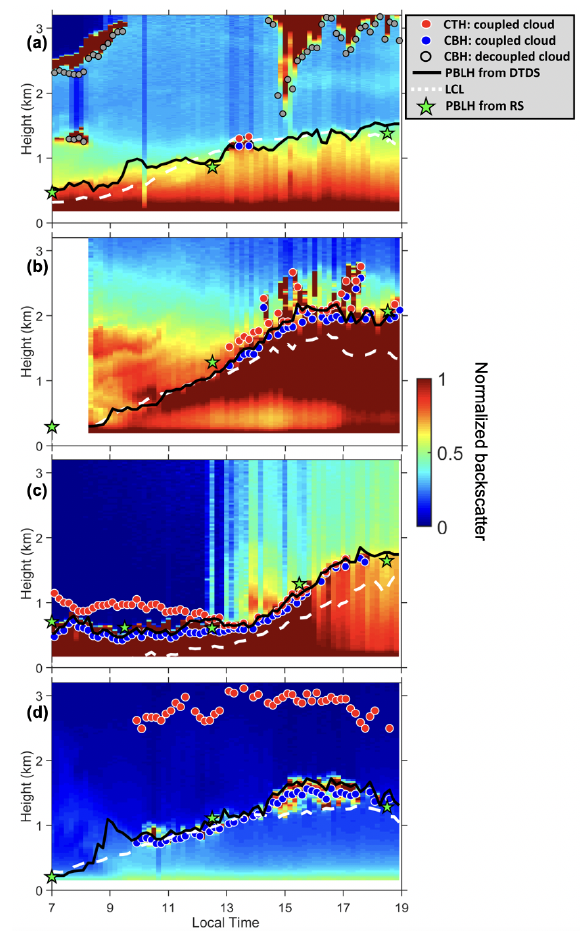
Figure 8. Daily backscatter profiles: (a) short-lived coupled cloud, (b) developed coupled cloud, (c) daylong coupled cloud, and (d) ac- tive coupled cloud. Backscatter is normalized to a range of 0– 1 in arbitrary units. Red dots and blue dots indicate cloud-top heights (CTHs) and cloud-base heights (CBHs) of coupled clouds. Grey dots mark CBHs for decoupled clouds. Black lines and green stars mark the planetary boundary layer height (PBLH) retrieved from the DTDS algorithm and from radiosonde (RS) soundings, re- spectively. Dashed white lines represent lifted condensation levels